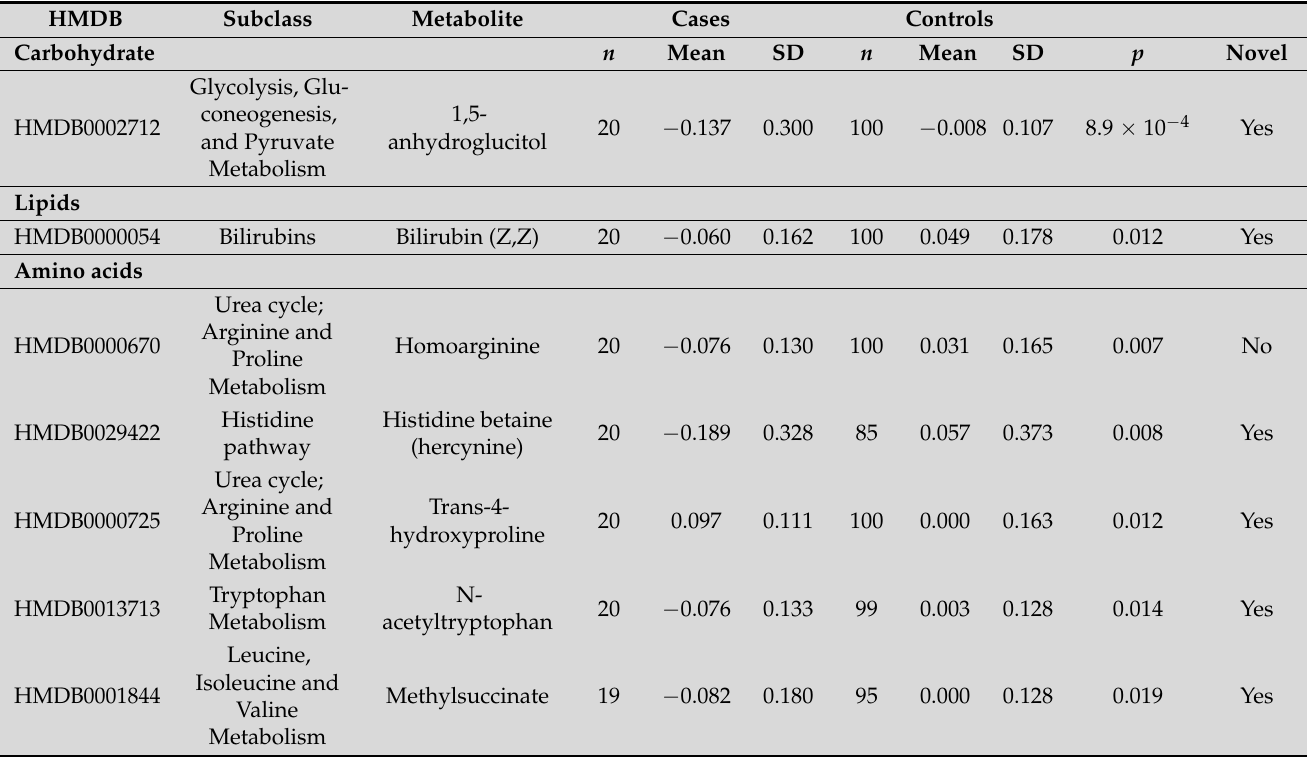
Table 4. Statistically significant differences in metabolite concentrations between the carriers (Cases) and non-carriers (Controls) of the pathogenic or likely pathogenic DCM